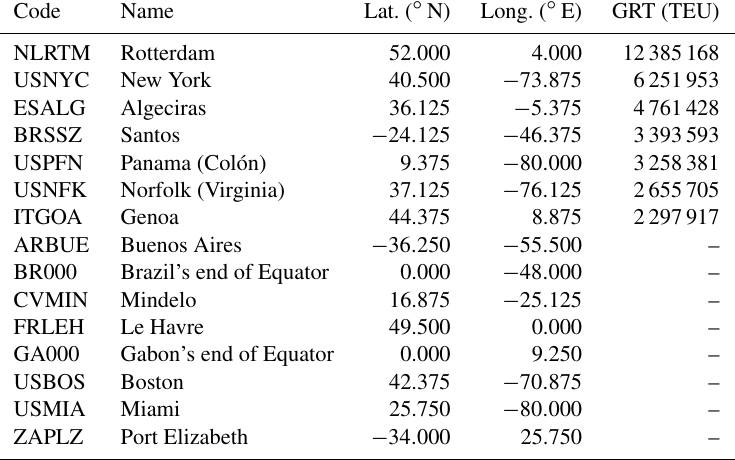
Table 6. Database of harbours. Coordinates refer to the graph grid point selected by VISIR. Wherever available, GRT is the annual throughput for the year 2016 from Lloyd’s (2018) and is used for sorting the entries. The other harbours are sorted alphabetically, following international seaport codes.